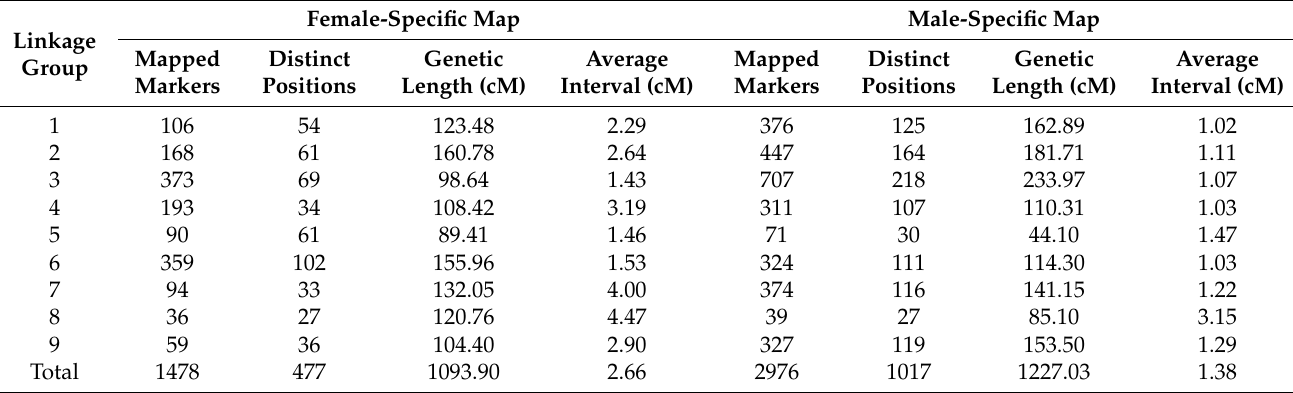
Table 2. Summary of the sex-specific linkage maps of citrus.